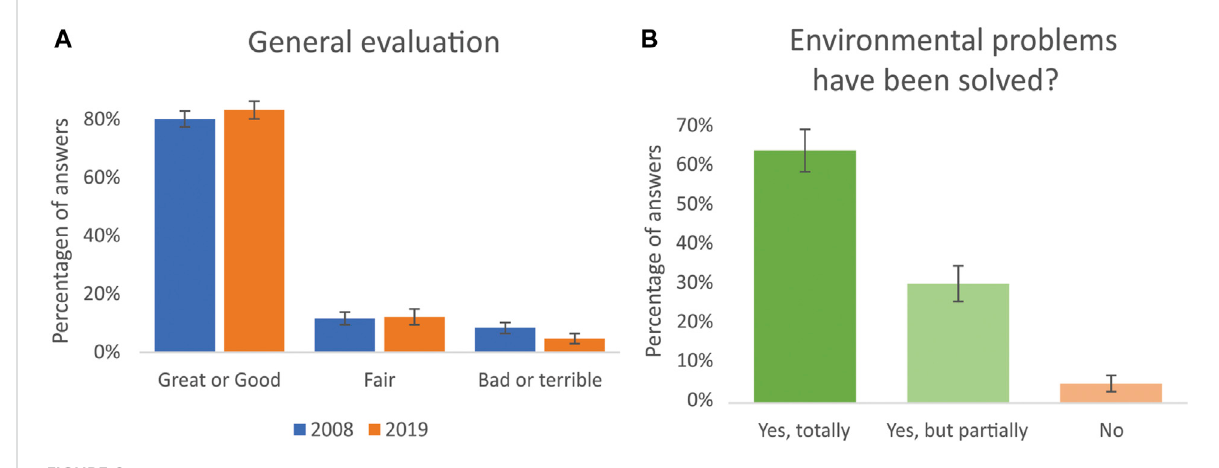
FIGURE 8 Acceptance of rehabilitation projects: (A) general evaluation and (B) if major environmental problems were solved.